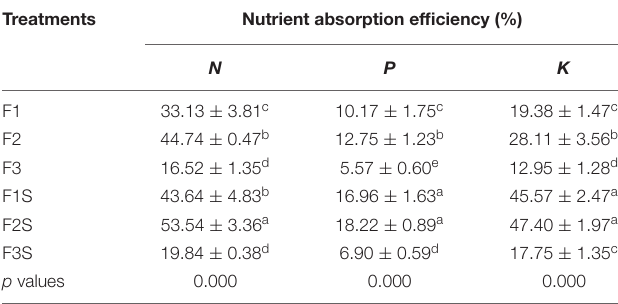
Values are presented as mean ± standard error from 10 replicates each treatment. Different letters indicate significant differences among treatments (Tukey’s test, P ≤